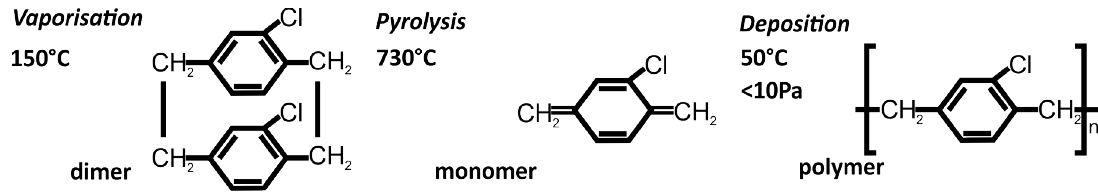
Figure 1. The deposition process of parylene-C. First, parylene-C dimer powder or granulate is vaporized at 150°C, followed by a pyrolysis step at 730°C to obtain parylene-C diradical monomers. At a temperature of 50°C and a pressure of approximately 10Pa, the monomer vapor condensates and forms a conformal coating on the